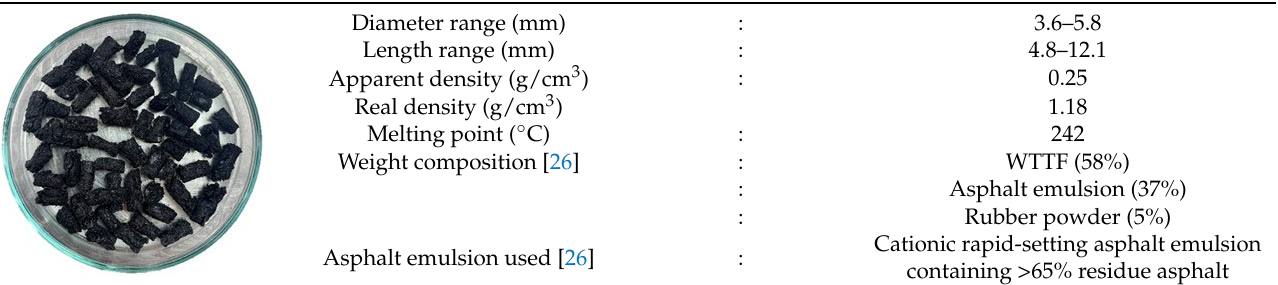
Table 1. Characterization of the WTTF ‐ based additive.